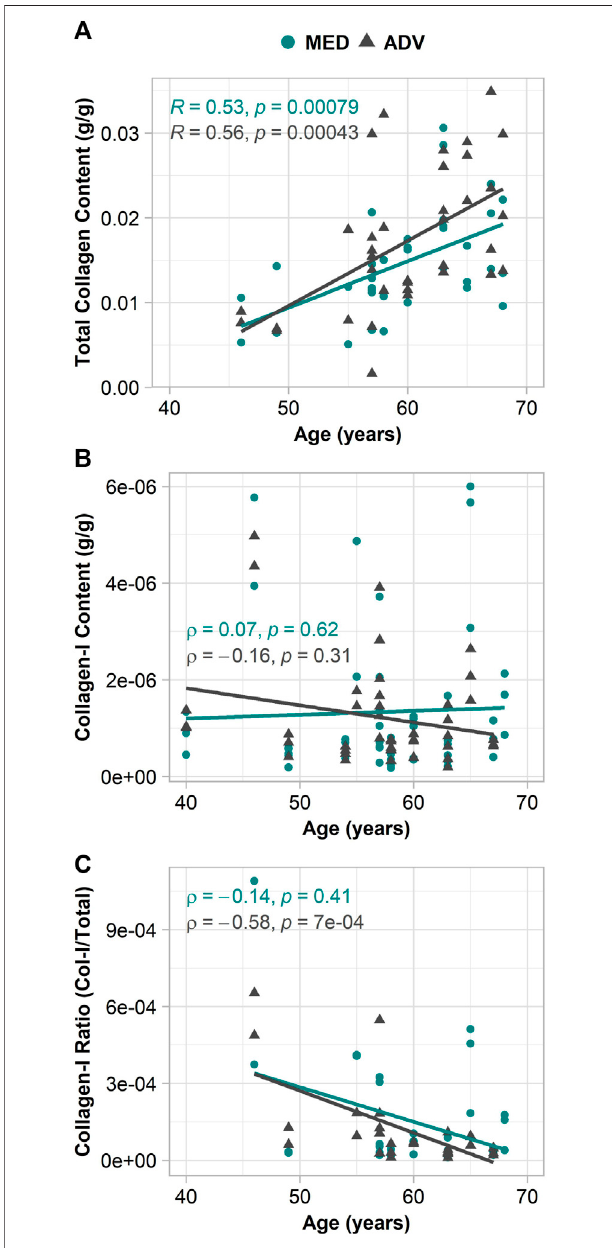
FIGURE 3 | Relationship of collagen in the adventitia and media with patient age. (A) total collagen content; (B) collagen-I content; (C) collagen- I